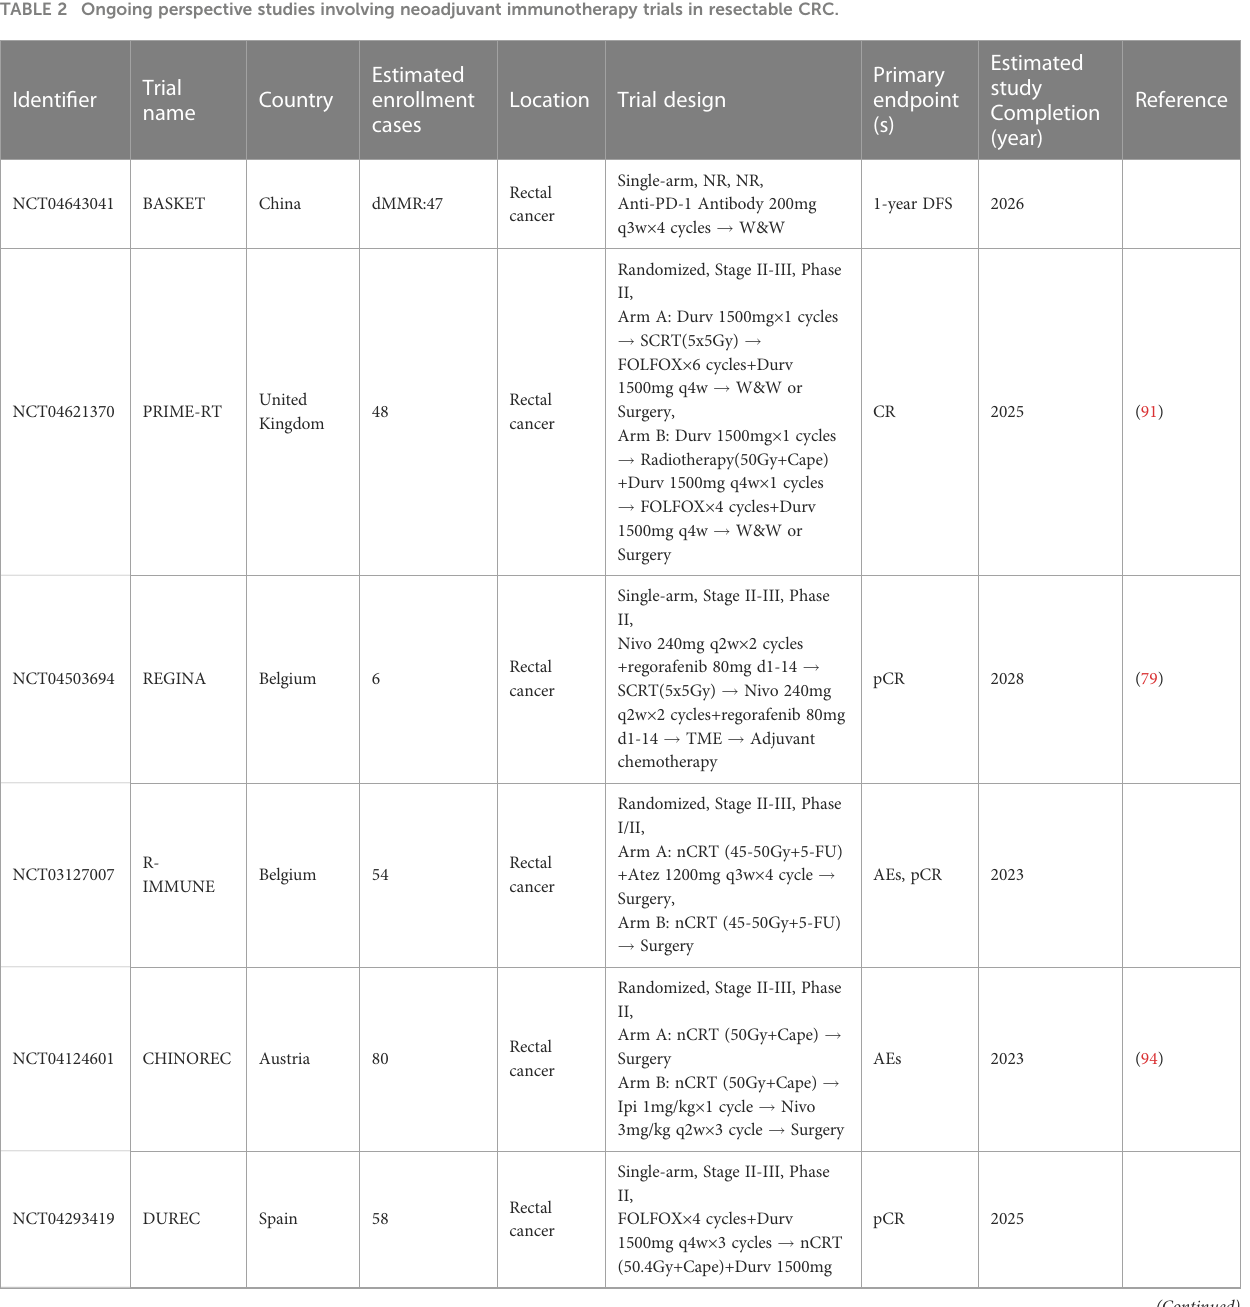
TABLE 2 Ongoing perspective studies involving neoadjuvant immunotherapy trials in resectable